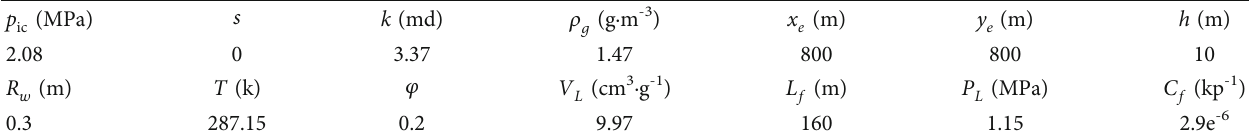
Figure 8: The calculation method selection between the Riley method and discrete method. Table 2: Example of single well basic